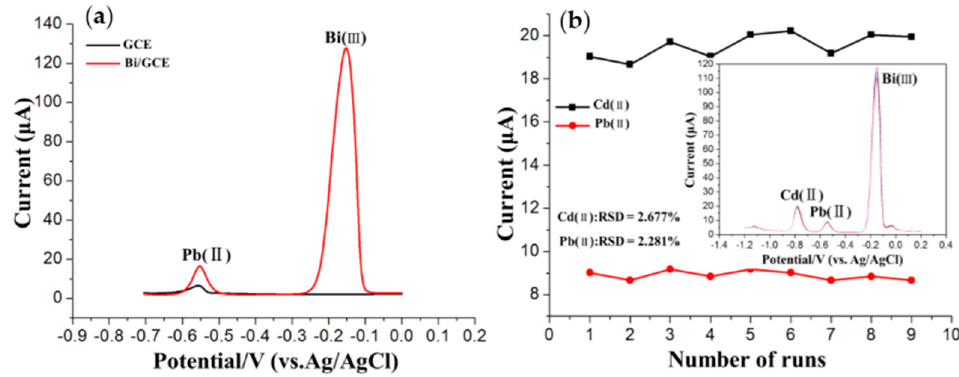
Figure 3. ( a ) Square wave anodic stripping voltammograms of 35 µ g/L Pb(II) in 0.1 M acetate buffer solution (pH 5.0) on GCE and Bi/GCE. Deposition time: 140 s; deposition potential: − 1.2 V; concentration of Bi(III): 600 µ g/L; ( b ) Stripping current measurements of 25 µ g/L Cd(II) and Pb(II) on Bi/GCE in 0.1 M acetate buffer solution (pH 5.0). The insets correspond to data collected from every SWASV response over nine repetitions. RSD: relative standard deviation.